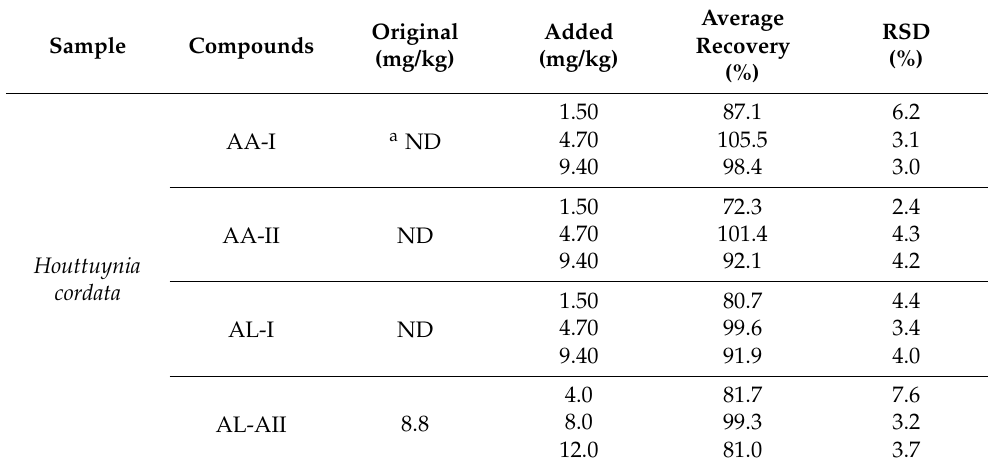
Table 4. Recovery and precision for the determination of the investigated compounds ( n = 6).